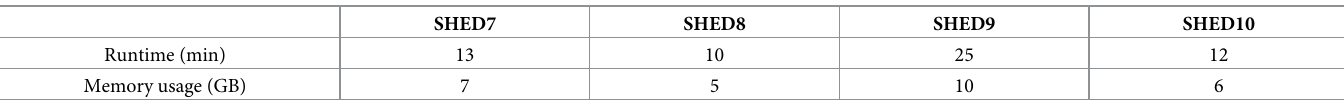
Table 3. Performance